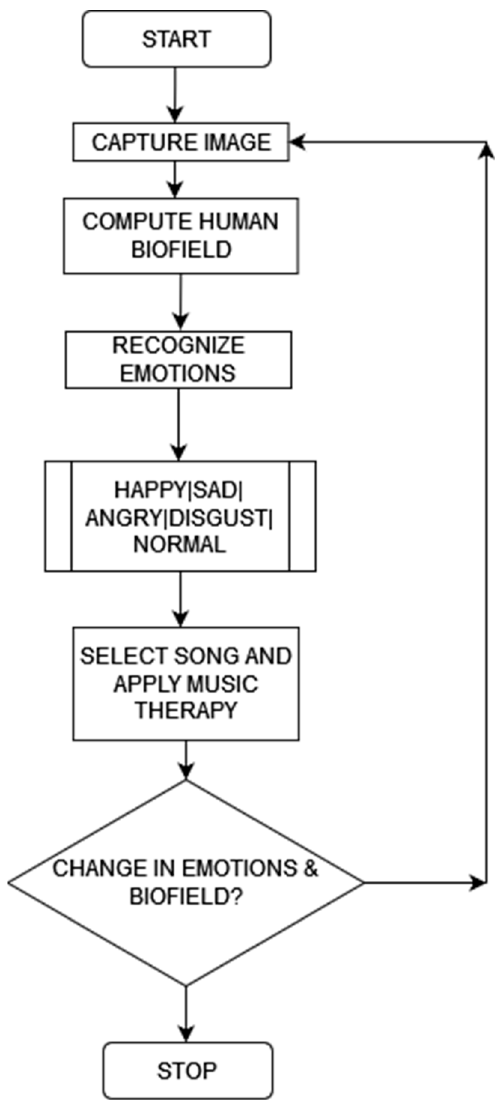
Figure 1. Working model of the proposed methodology.